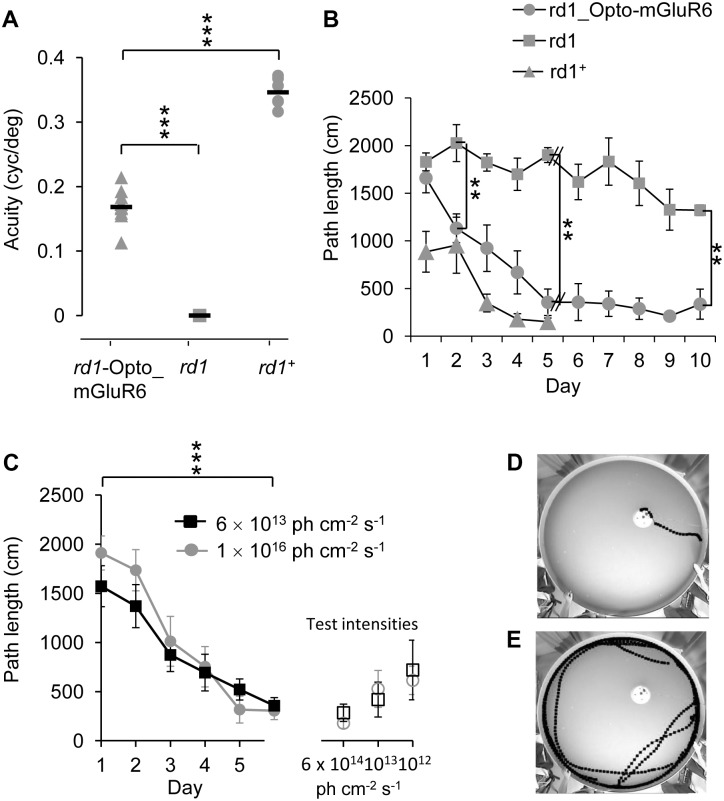
Visual performance determined in behavioral experiments.(A) rd1_Opto_mGluR6 mice (n = 11) had optokinetic reflexes with a peak spatial acuity of 0.17 ± 0.04 cyc/deg, rd1 littermates (n = 8) did not respond to any frequency, and seeing Pde6b
+ mice (n = 6) responded with a peak acuity of 0.35 ± 0.05 cyc/deg. Stimulus intensity 5.6 × 1013 photons cm-2 s-1. (B) The total swim distance to a hidden platform in a water maze marked by an overhead blue light-emitting diode (LED). From training day 2, rd1_Opto-mGluR6 mice (n = 6) learned to find the platform significantly faster than their blind rd1 littermates (n = 5) but not significantly slower than Pde6b
+ mice (n = 3). Stimulus intensity 1 × 1016 photons cm-2 s-1. (C) Sensitivity of behavioral vision. rd1_Opto-mGluR6 mice were trained for 6 d at high and low light intensities (left) and subsequently tested for their visual performance at three test intensities (right). Nonsaturating training light intensities did not compromise learning, and the performance at the three test intensities did not differ significantly. Error bars indicate SEM in B and C. (D,E) Example paths swam by rd1_Opto-mGluR6 and rd1 mice, respectively, on training day 10.